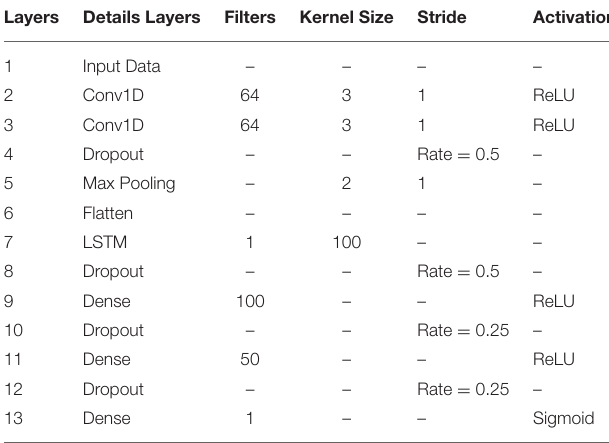
TABLE 7 | The details of the second proposed CNN-LSTM